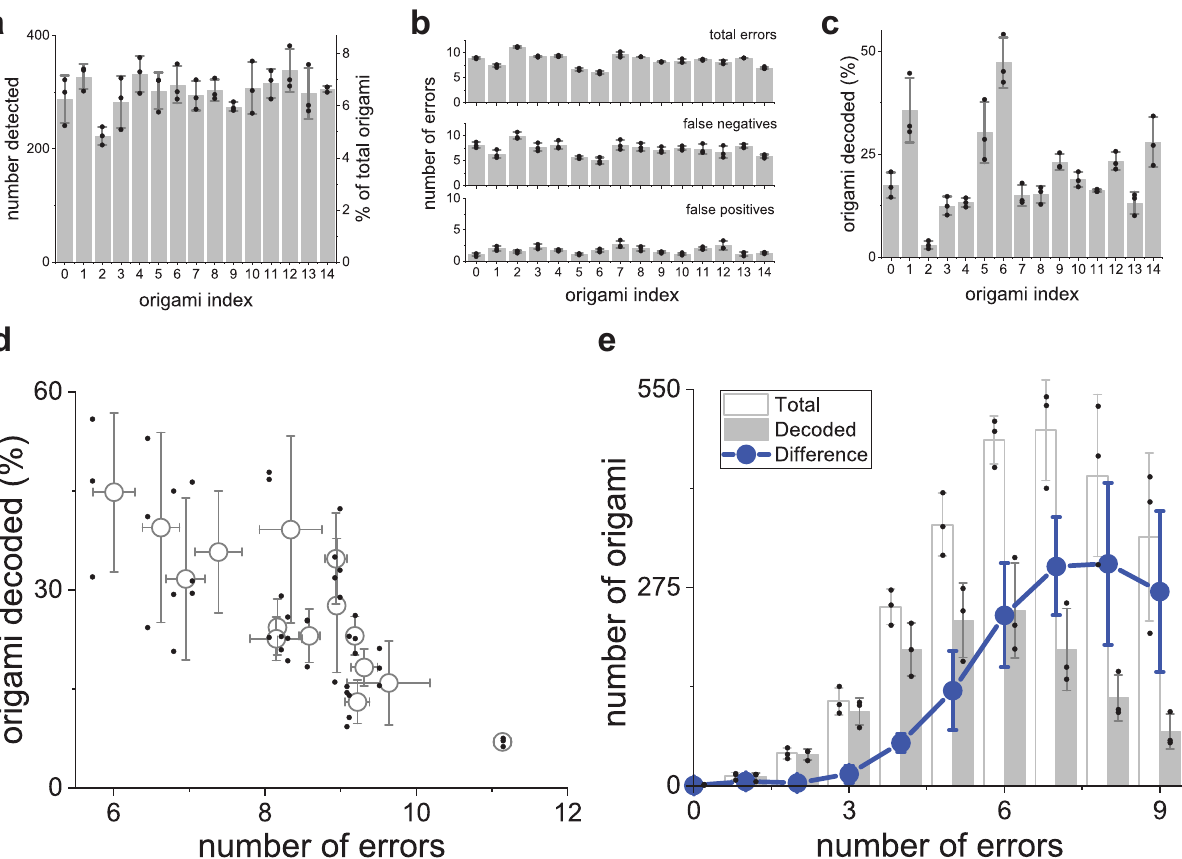
Fig. 3 All 15 dNAM data strings were recovered from a single read. (a) plots the numbers of each origami index observed in a single recording, based on template matching. The mean counts are shown as gray bars, with the percentage of the total origami indicated on the secondary axis. In ( b ), the mean number of total errors (top) for each structure is shown, based on template matching. The same errors are also shown after being grouped into false negatives (middle) and false positives (bottom). ( c ) depicts the percent of origami passed to the decoding algorithm that had both their indexes and data strings correctly identi fi ed. In ( d ), the percentage of each origami decoded is plotted against the mean number of errors for each structure. ( e ) shows histograms of the total mean numbers of errors found in origami identi fi ed by template matching (open bars) and the decoding algorithm (gray bars). The difference between the two is plotted in blue. Mean values for three experiments are depicted in all graphs, error bars indicate ±SD. Individual data points are plotted as small black